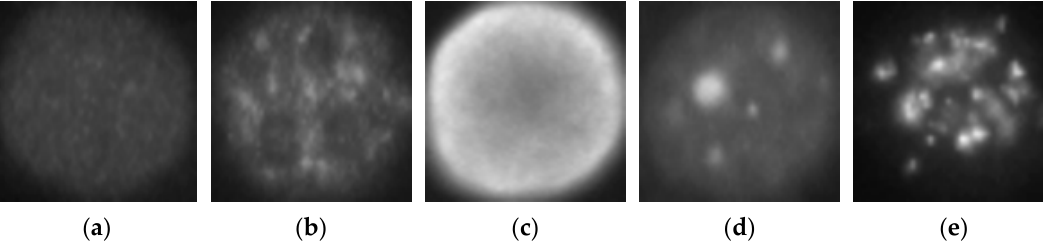
Figure 8. Example images from the SNPHEp-2 dataset. ( a ) The homogeneous, ( b ) the coarse speckled, ( c ) the fine speckled, ( d ) the nucleolar and ( e ) the centromere cells. The original size of the images is 112 × 112.